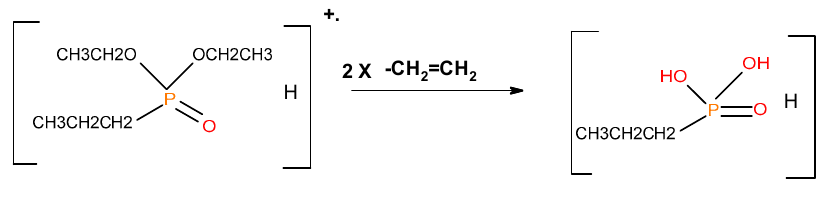
Figure 12. Possible fragmentation pattern for TEPa.